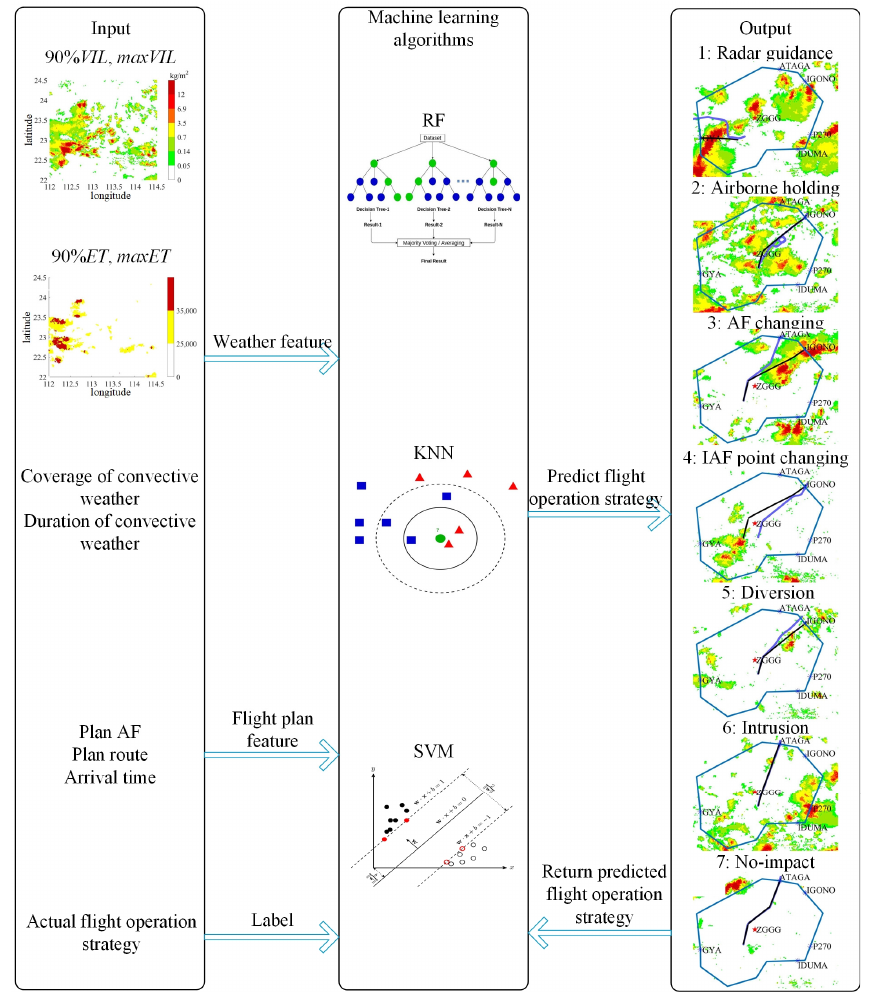
Figure 5. AFOSPM construction process.